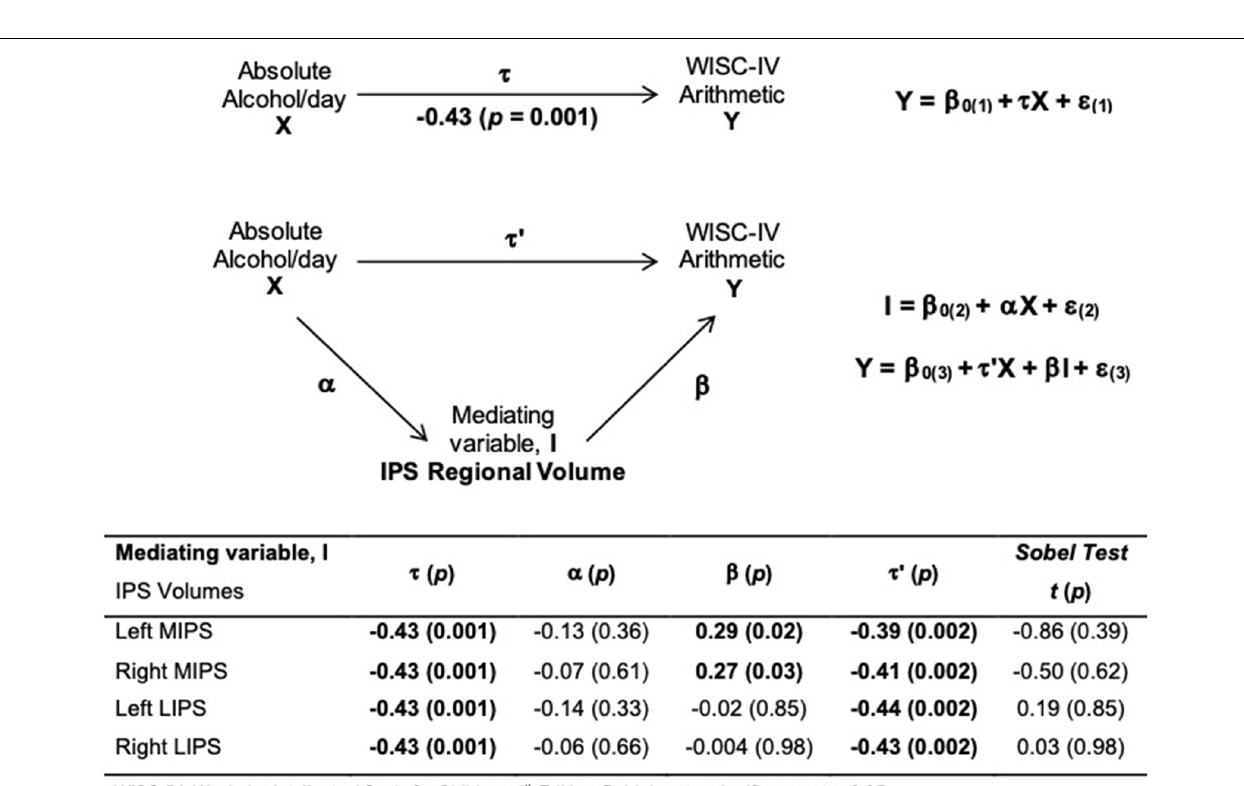
effects. Five key parietal areas for number processing have been suggested, including the left and right posterior SPL and the IPS, with its anterior portion being most active during the interpretation of magnitude (Dehaene et al., 2003). The location of the posterior SPL delineated by Dehaene et al. (2003) and used by Woods et al. (2015) in fMRI studies of number processing corresponds neuroanatomically with the medial branch of the